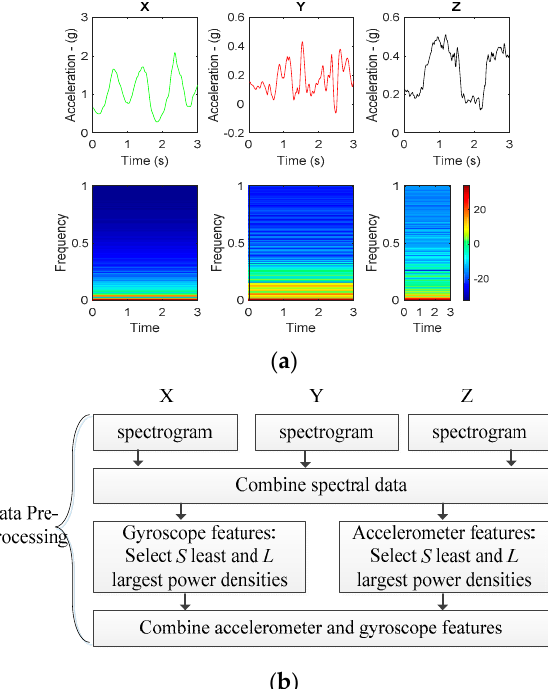
Figure 4. ( a ) An example of time domain data and their spectrogram representing walking data; ( b ) Proposed feature extraction algorithm.